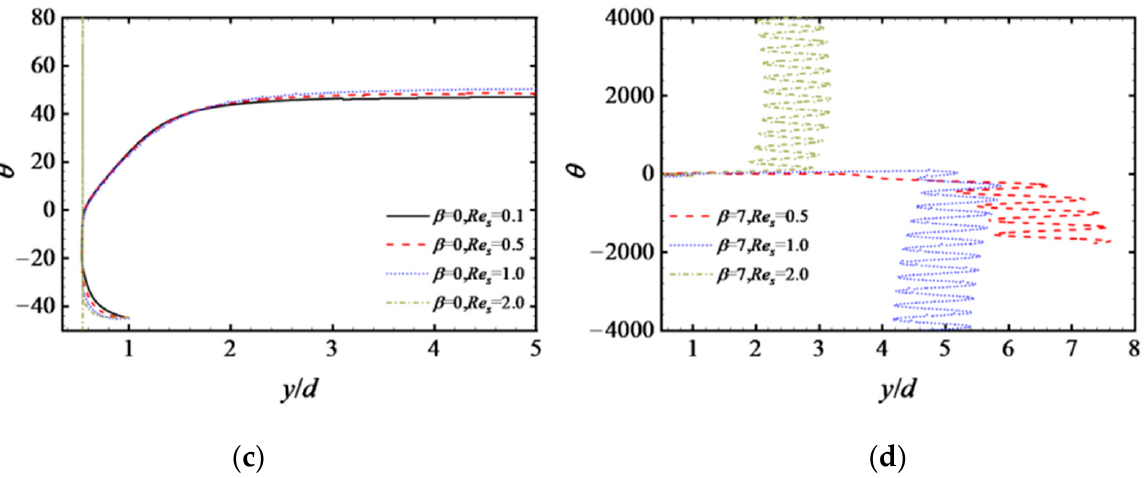
Figure 10. Phase diagram of the trajectory of rod-shaped squirmers at different values of Re s ( s = d , i = 2): ( a ) β = − 3; ( b ) β = 3; ( c ) β = 0; ( d ) β = 7.